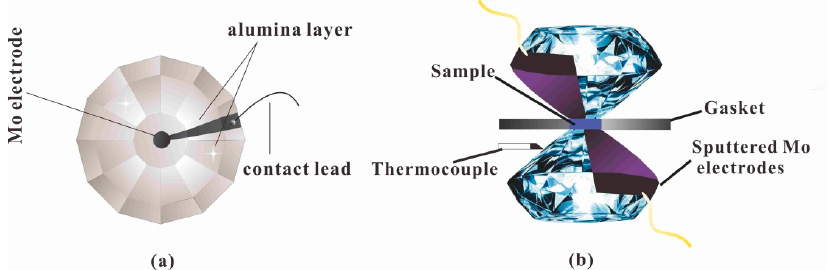
Figure 2. Measurement assemblage of sample for electrical conductivity at high pressure. ( a ) The structure of plate electrodes integrated on two diamond anvils. ( b ) Cross section of the diamond anvil cell (DAC) employed in the high-pressure electrical conductivity measurement.